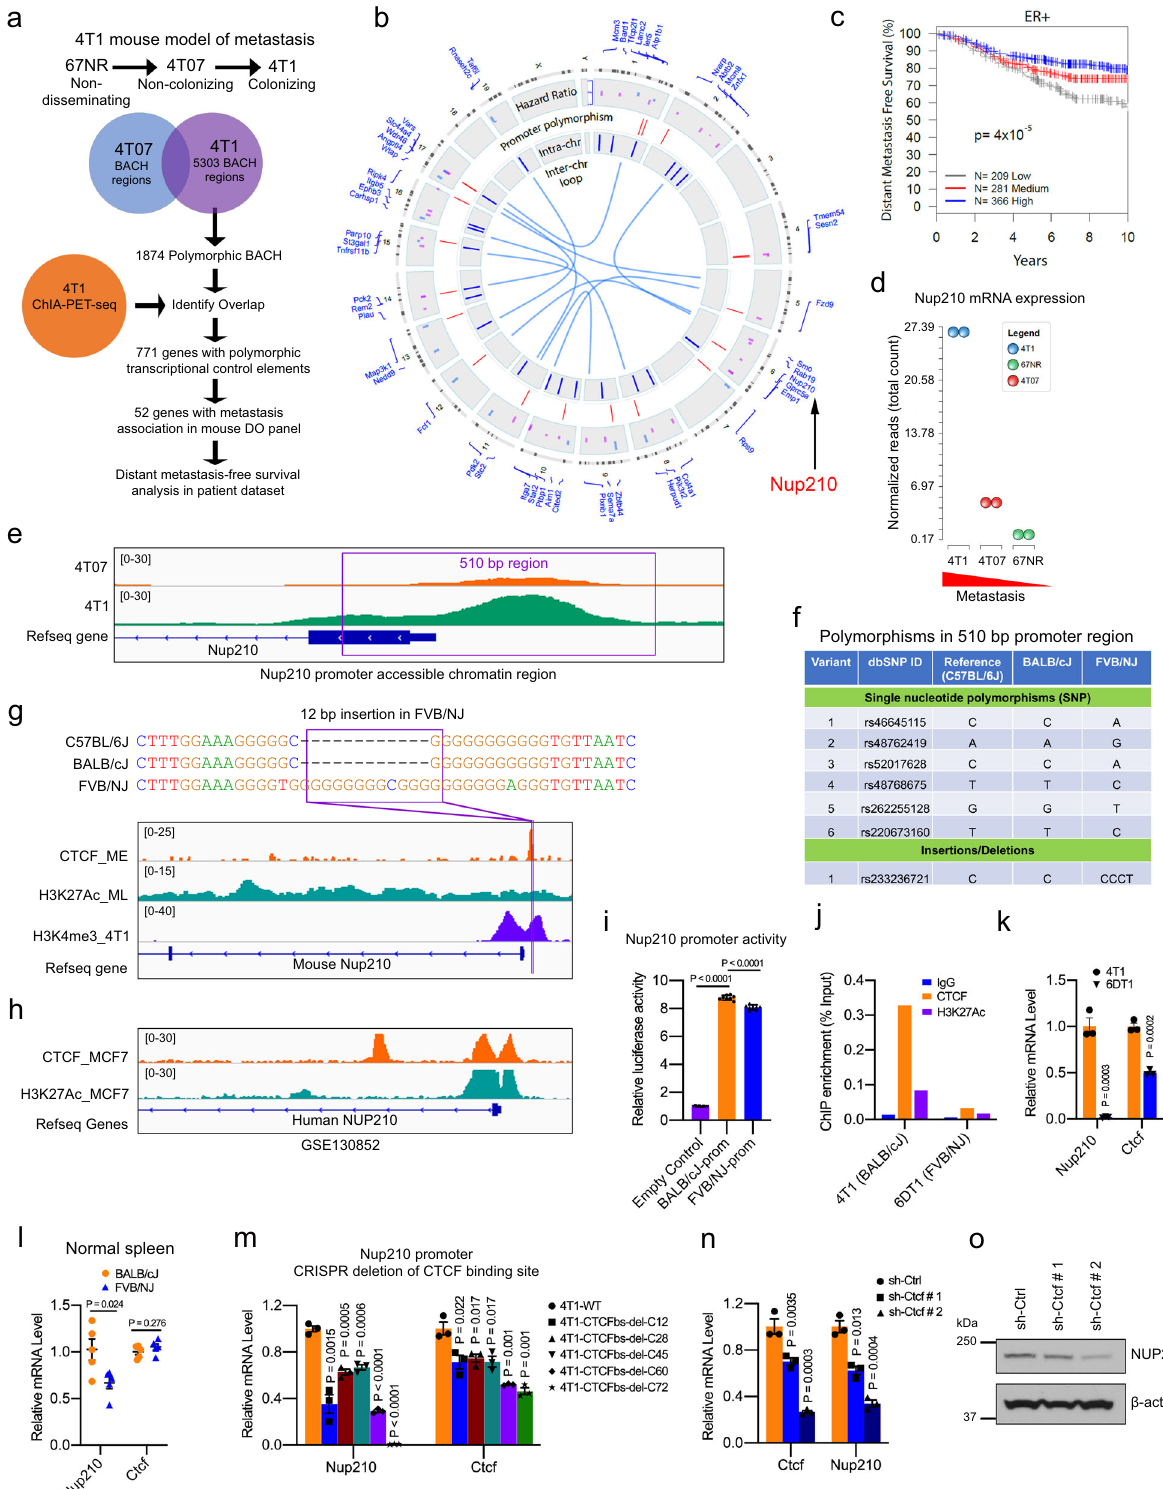
Taxonomy of Breast Cancer International Consortium (METAB- RIC) dataset 23 (Fig. 2a). Two independent human breast cancer gene expression datasets suggested that NUP210 mRNA expression was signi fi cantly associated with reduced overall survival (Fig. 2b, METABRIC) and DMFS (Fig. 2c, Km plotter) 24 in estrogen receptor-positive (ER + ) breast cancer patients. However, the patient survival outcome appears to be moderate in these